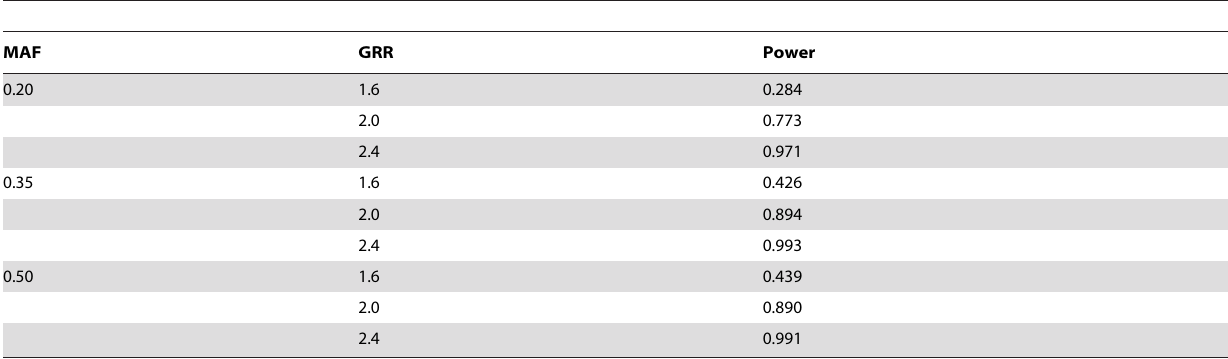
Table 4. Power was computed using TDT Power Calculator [15] varying SNP minor allele frequency (MAF) and genetic relative risk (GRR).